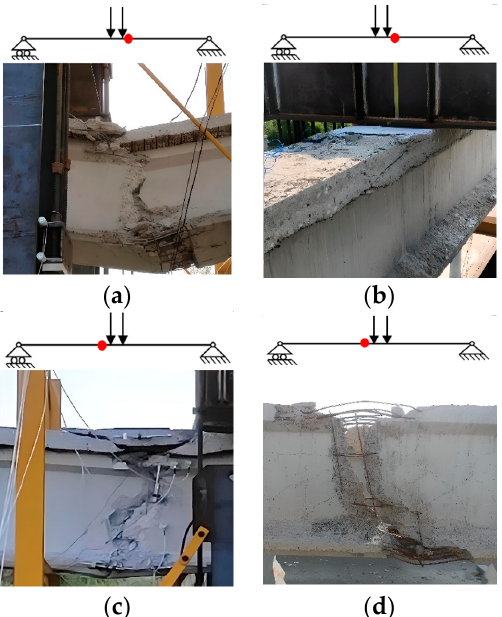
Figure 11. Failure zone details for: ( a ) B3-P47/46, ( b ) B8-P47/46, ( c ) B4-P47/46, ( d ) B9-P47/46 and the corresponding position.